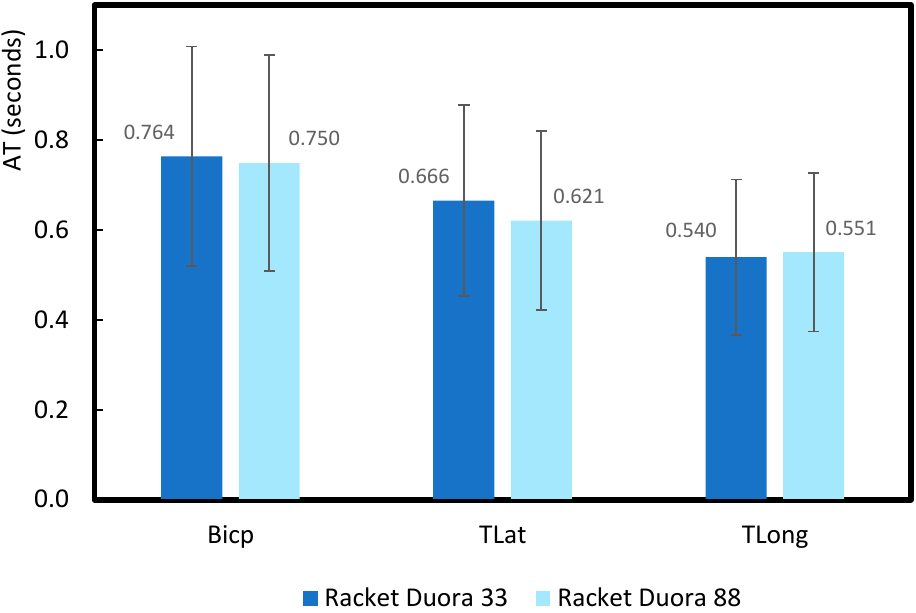
Figure 7. Average muscle activation time and standard deviation.